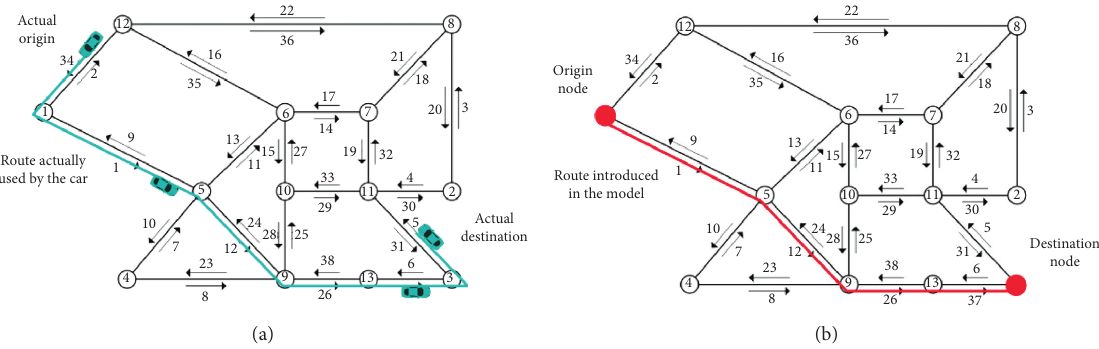
Figure 4: Origin and destination nodes’ definition: (a) route actually used by a certain vehicle; (b) route to be included in the traffic